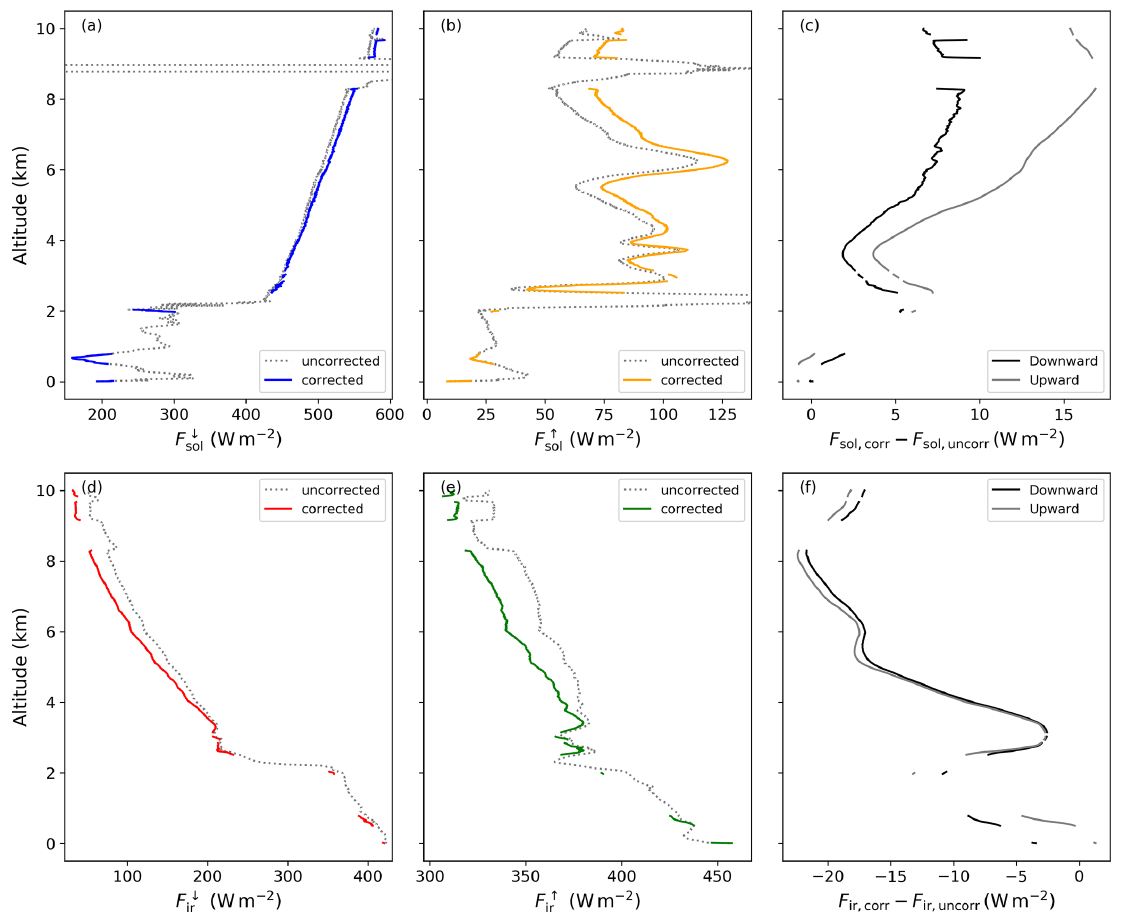
Figure 7. Vertical profiles of downward solar (a) , upward solar (b) , downward thermal–infrared (d) , and upward thermal–infrared (e) irradi- ance given by the solid lines measured right after the start of the research flight on 7 February 2020 (flight ID HALO-0207). The dotted gray lines indicate the corresponding profiles prior to the dynamic thermal correction. Panels (c) and (f) show the absolute differences between the corrected and uncorrected profiles (downward: black, upward: gray) for both the solar and thermal–infrared